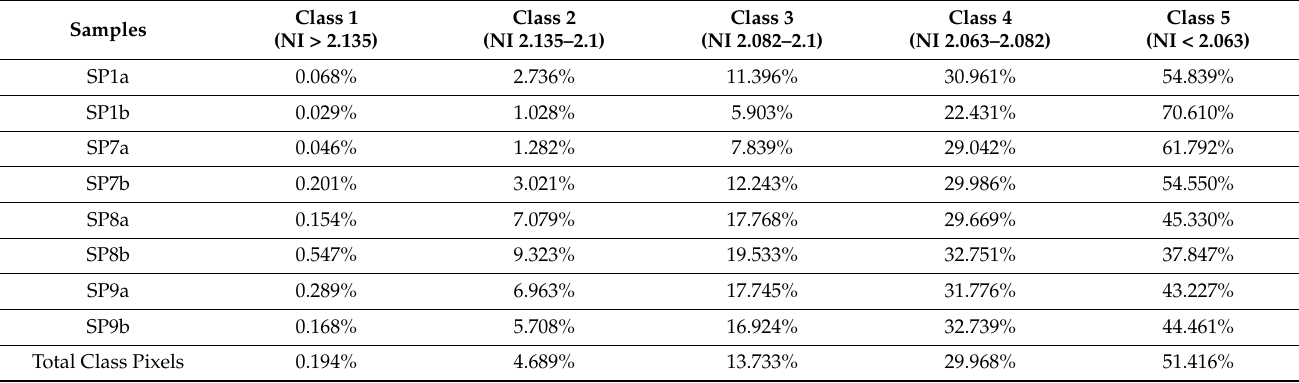
Figure 10. A decision tree classifier is used to delineate the quantitative spatial distribution of Nd in the sample SP8b. The root node represents the original VNIR image of the sample SP8b and calculates the total number of pixels in the image. The classifier splits the total number of pixels into different classes based on the NI value introduced at the root node as well as each of the split nodes, and calculates the percentage of pixels included in each of the five classes. The pixel distribution of each of the classes is shown in the sample image. Table 1. The percentage of pixels present in each class of the